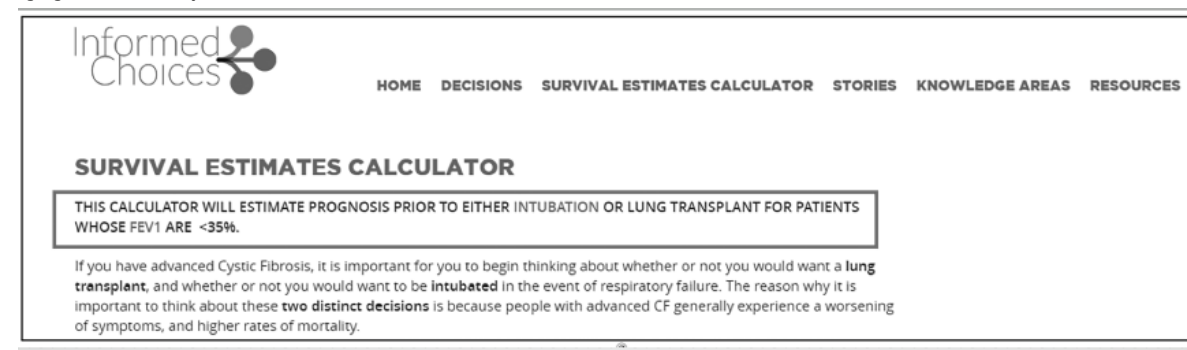
Figure 3. Survival estimates calculator. The initial phrase explaining the survival estimates calculator has been visually emphasized by bolding and enlarging the font. CF: cystic